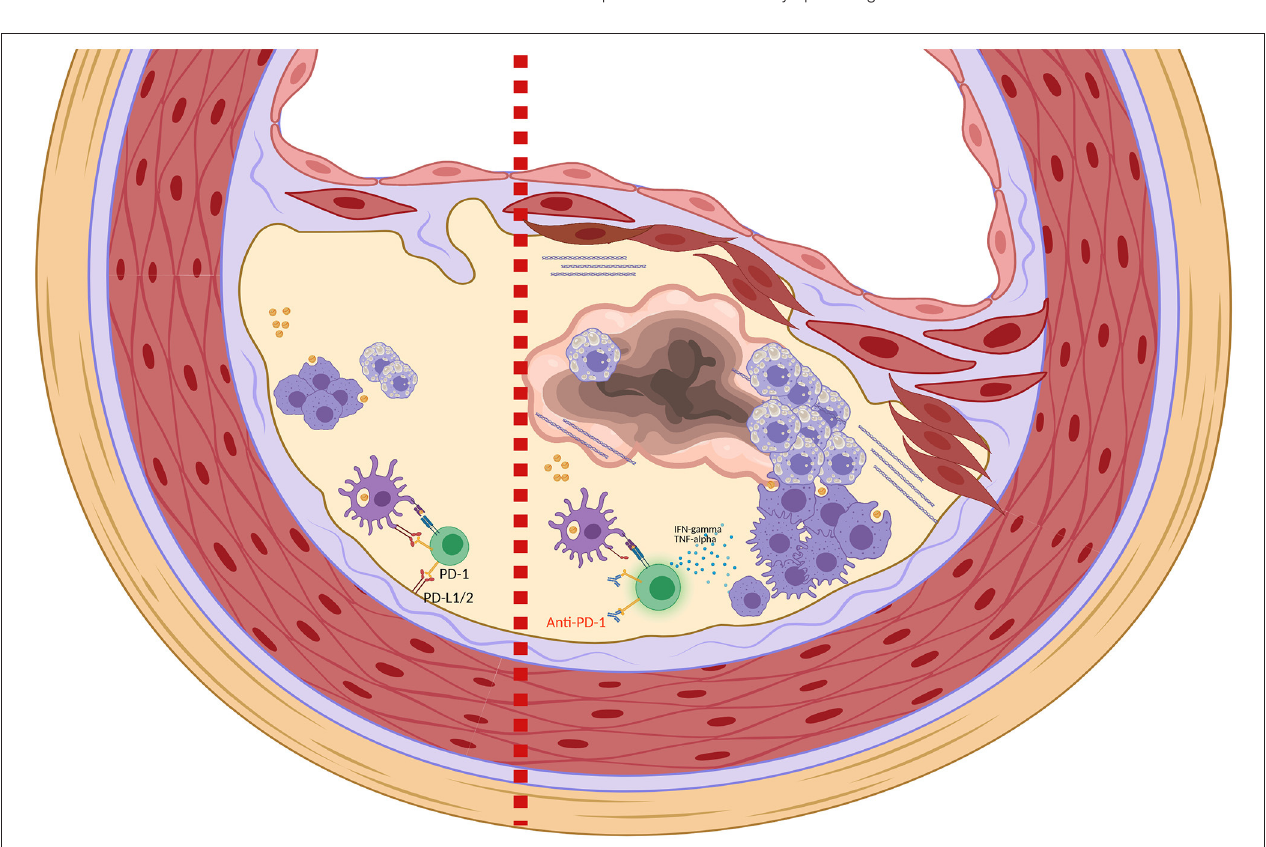
FIGURE 1 | Role of PD-1 and PD-1 blockade in the homeostasis of atherosclerotic plaque. Left side: Binding of PD-1 expressed on T-cells with PD-L1/PD-L2 expressed on DCs and in microenvironment contribute to the inactivation of T-cells and to the maintenance of an immunosuppressive plaque microenvironment. Right side: Anti-PD-1 leads to T-cells activation with production of proinflammatory cytokines such as TNF- α and IFN γ . TNF- α and IFN γ promote smooth muscle cell proliferation, collagen deposition and activation of macrophages that increase the phagocytosis of LDL with transformation into foam cells (8, 9). These changes in the plaque structure ultimately lead to the formation of a necrotic core and plaque instability (Picture created with Biorender.com).